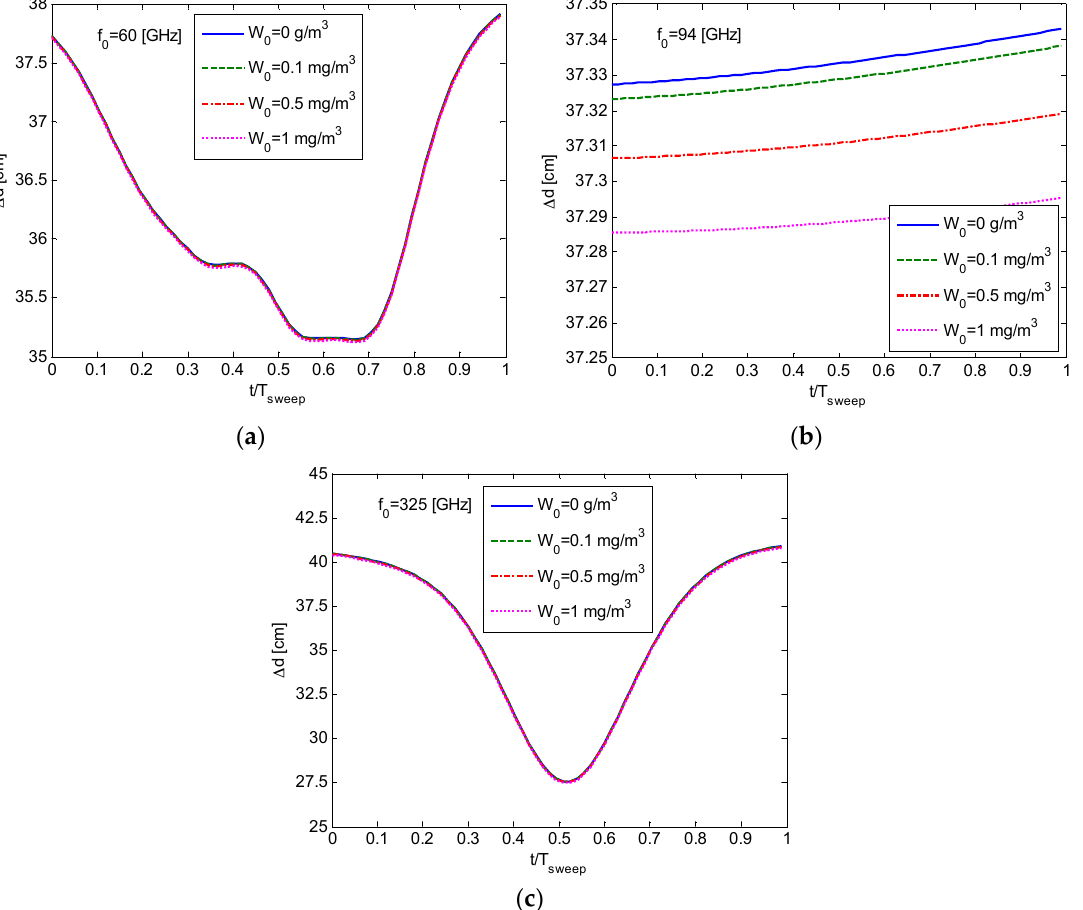
Figure 4. The range error in atmospheric foggy conditions. ( a ) 60 GHz; ( b ) 94 GHz; ( c ) 325 GHz.